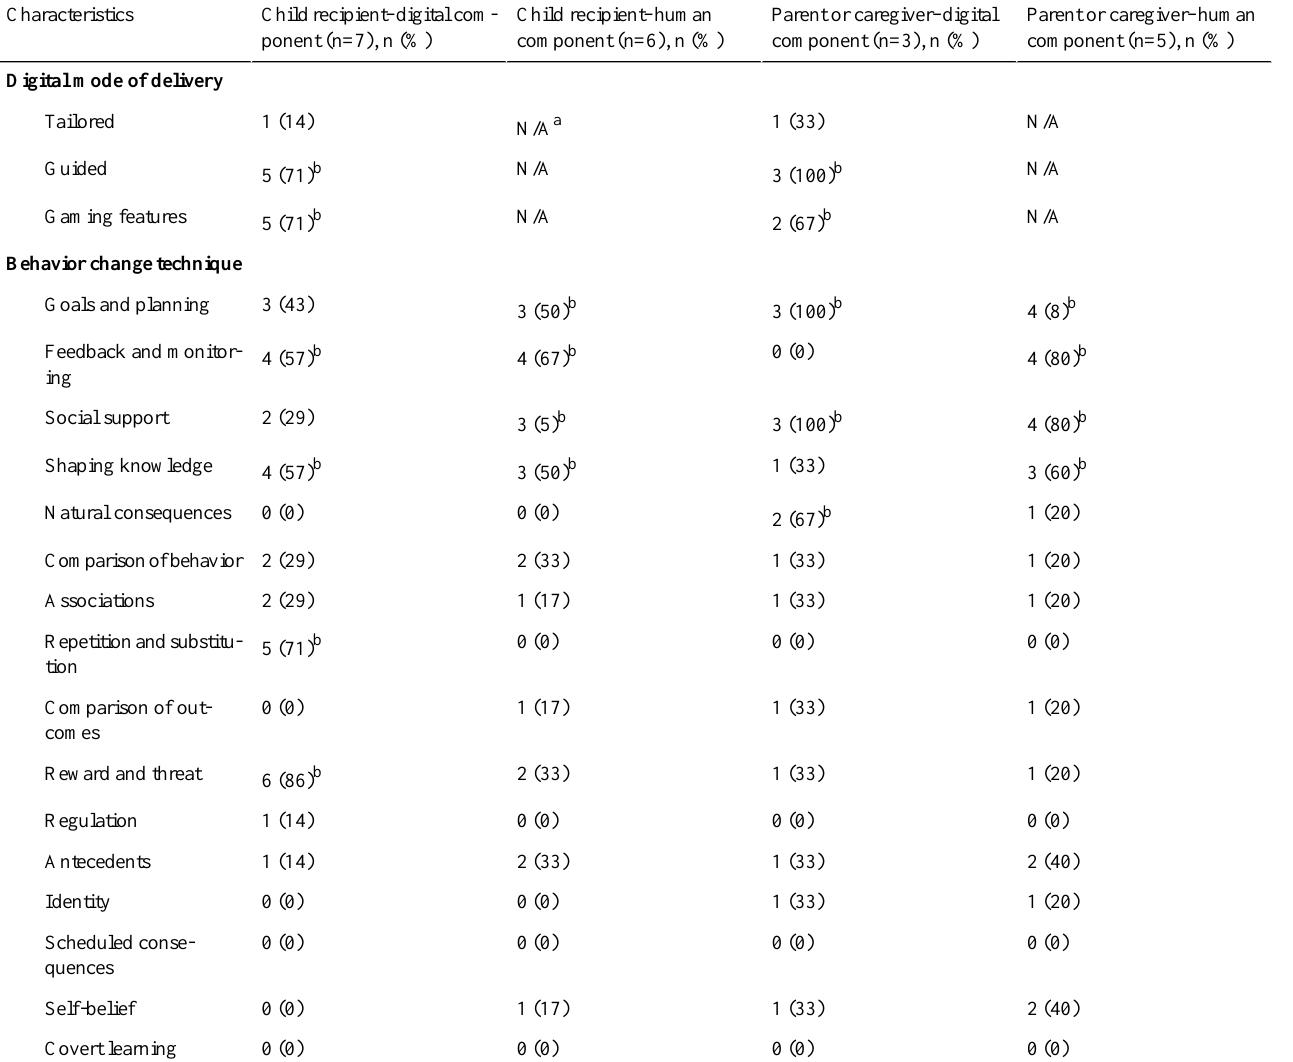
Table 5. Characteristics of promising interventions.